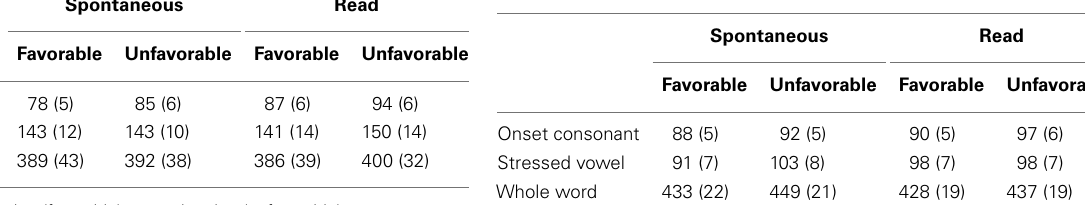
Table 6 | Mean durations in milliseconds (standard errors in brackets) for constituents of the second word of landmark phrases in the phonotactics condition: e.g., rickshaw in cream rickshaw (favorable) vs. drab rickshaw